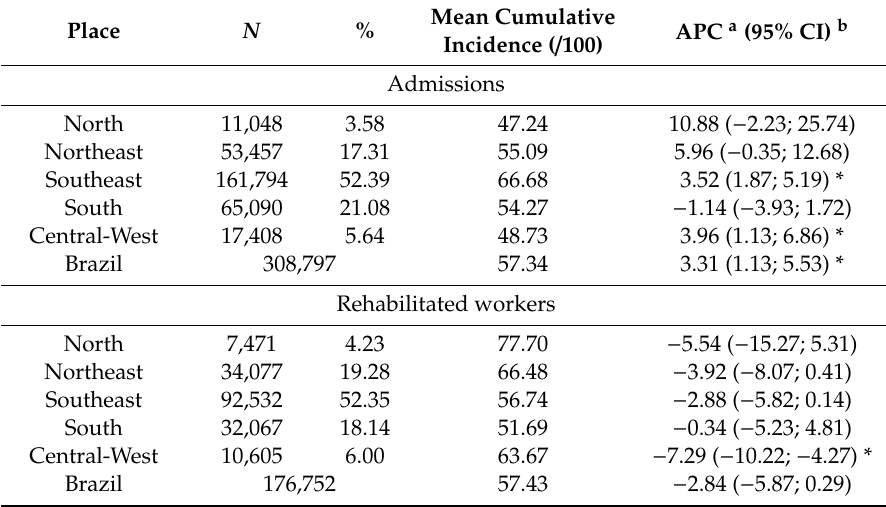
Table 2. Absolute and relative frequencies and mean cumulative incidence rates and trends relative to workers admitted to and rehabilitated at INSS vocational rehabilitation services. Brazil and macro-regions, 2007–2016. Mean Cumulative Place N % APC a (95% CI) b Incidence ( / 100) Admissions North 11,048 3.58 47.24 10.88 ( − 2.23; 25.74) Northeast 53,457 17.31 55.09 5.96 ( − 0.35; 12.68) Southeast 161,794 52.39 66.68 3.52 (1.87; 5.19) * South 65,090 21.08 54.27 − 1.14 ( − 3.93; 1.72) Central-West 17,408 5.64 48.73 Brazil 308,797 57.34 3.31 (1.13; 5.53) * Rehabilitated workers North 77.70 − 5.54 ( − 15.27; 5.31) Northeast 34,077 19.28 Southeast 52.35 56.74 South 32,067 18.14 51.69